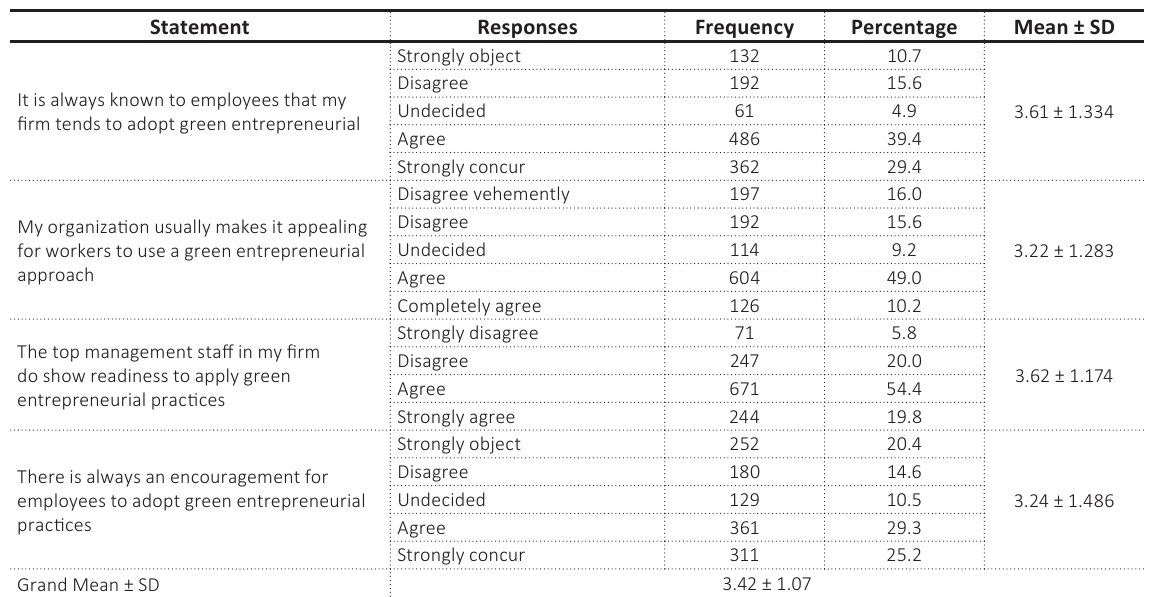
Table 7. Opinions on green entrepreneurial inclination